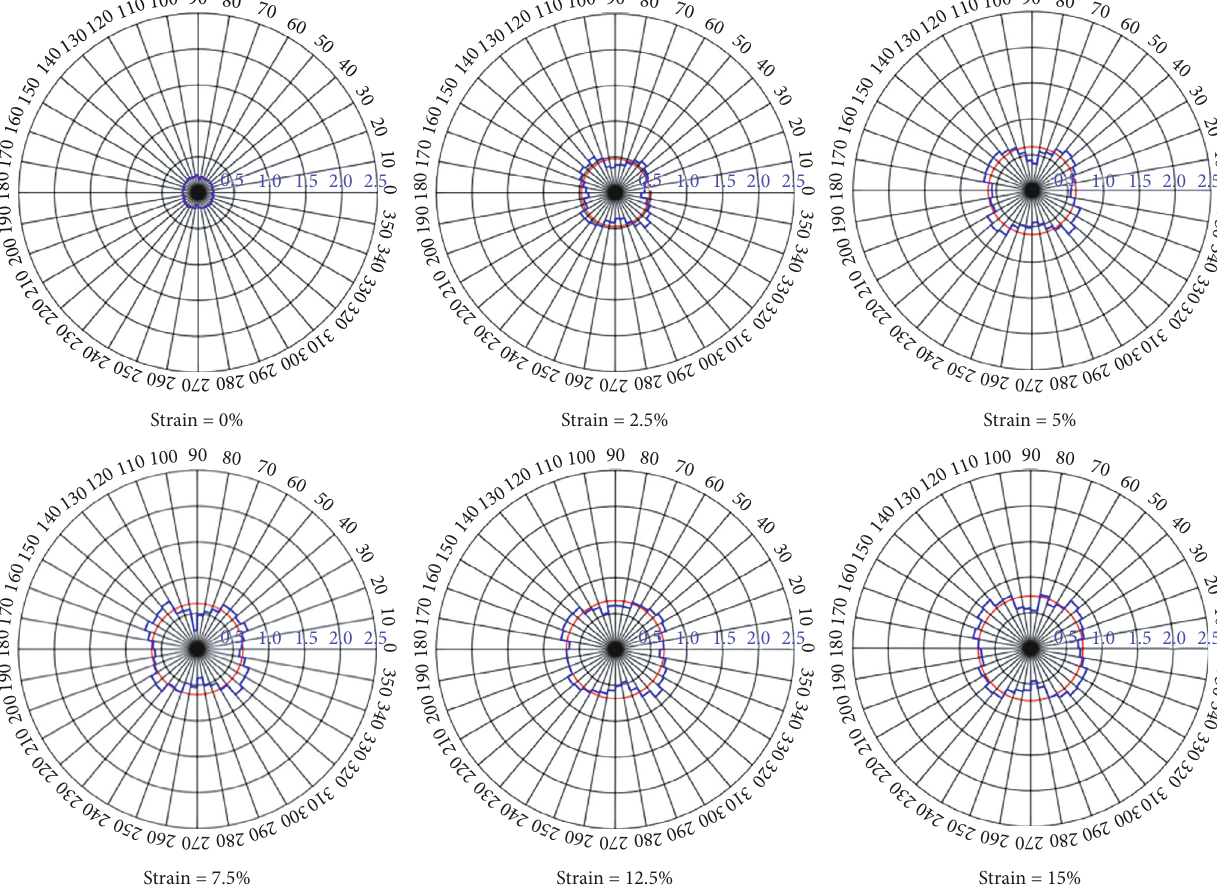
Figure 11: Statistical distribution of tangential contact force between particles in gravel soil mixture under di ff erent strains.